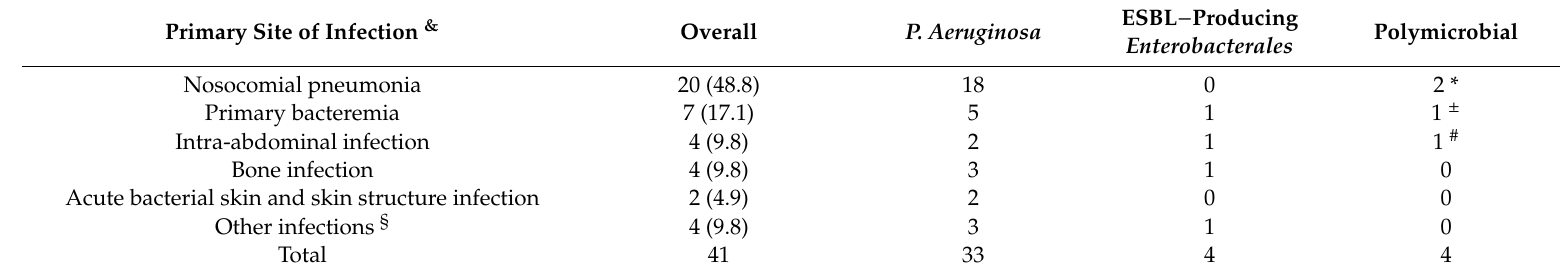
Table 2. Type of primary site of infection and causative agents.